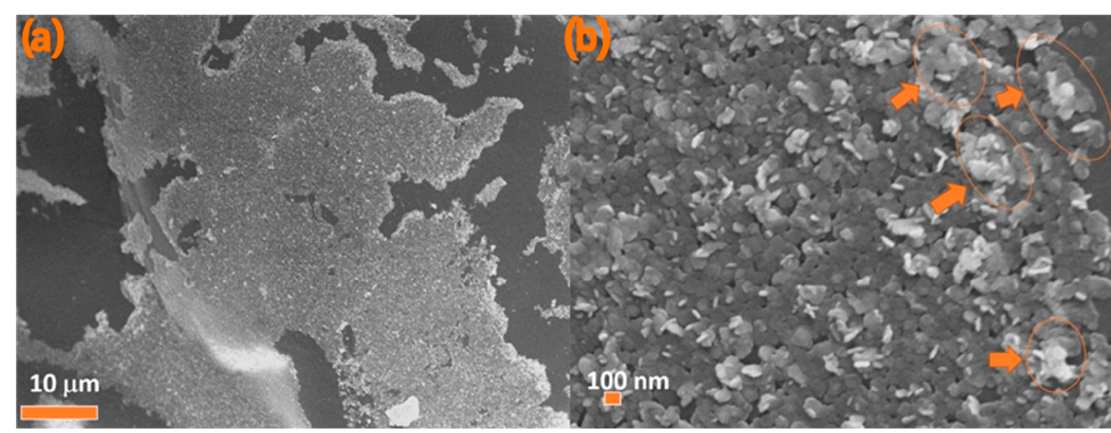
Figure 6. ( a ) SEM image of Sample 8 and ( b ) the magnification of ( a ). Figure 7. ( a ) SEM image of Sample 9 with ( b ) the magnification of ( a ) with arrows pointing at the aggregates of NPLs-Si in areas circled in orange.